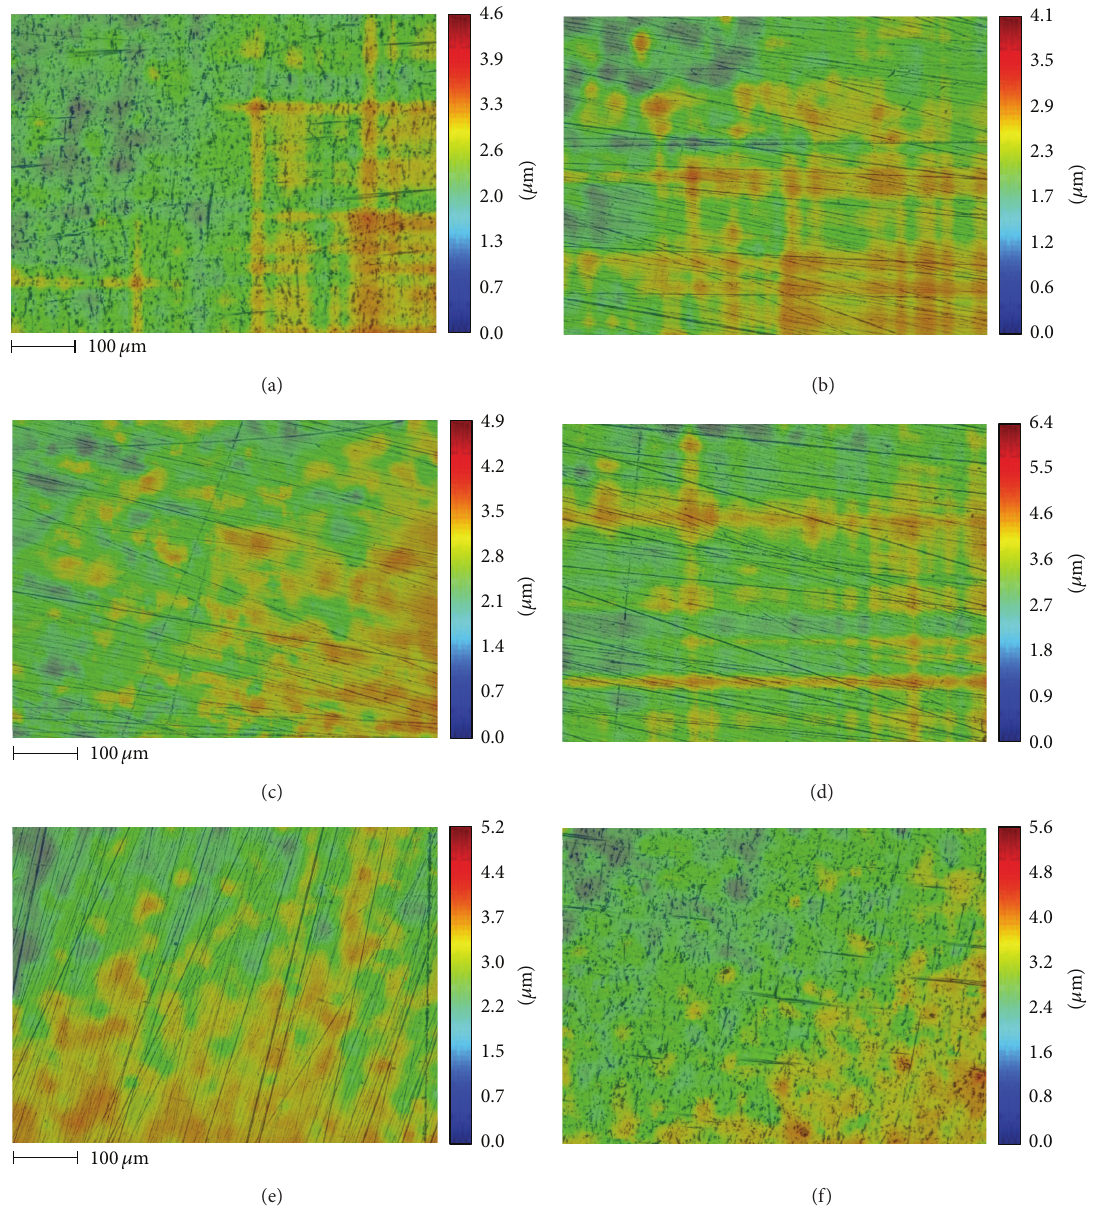
Figure 15: Depth cloud map of laser cladding specimens impacted by high speed droplets: (a) case 1, (b) case 2, (c) case 3, (d) case 4, (e) case 5, and (f) case